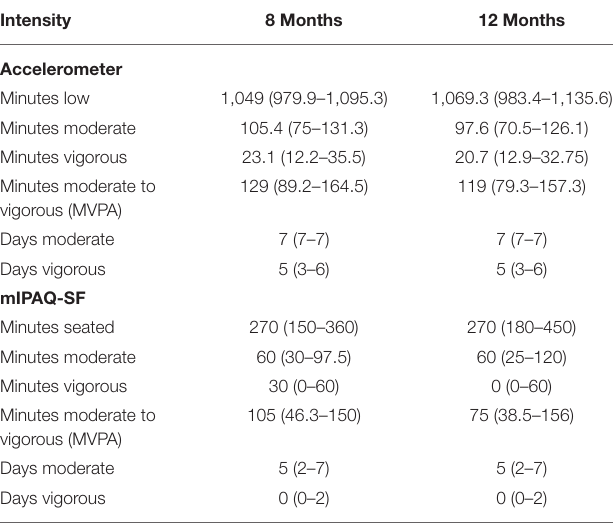
TABLE 2 | Values of the accelerometer and mIPAQ-SF measurements at 8 and 12 months.